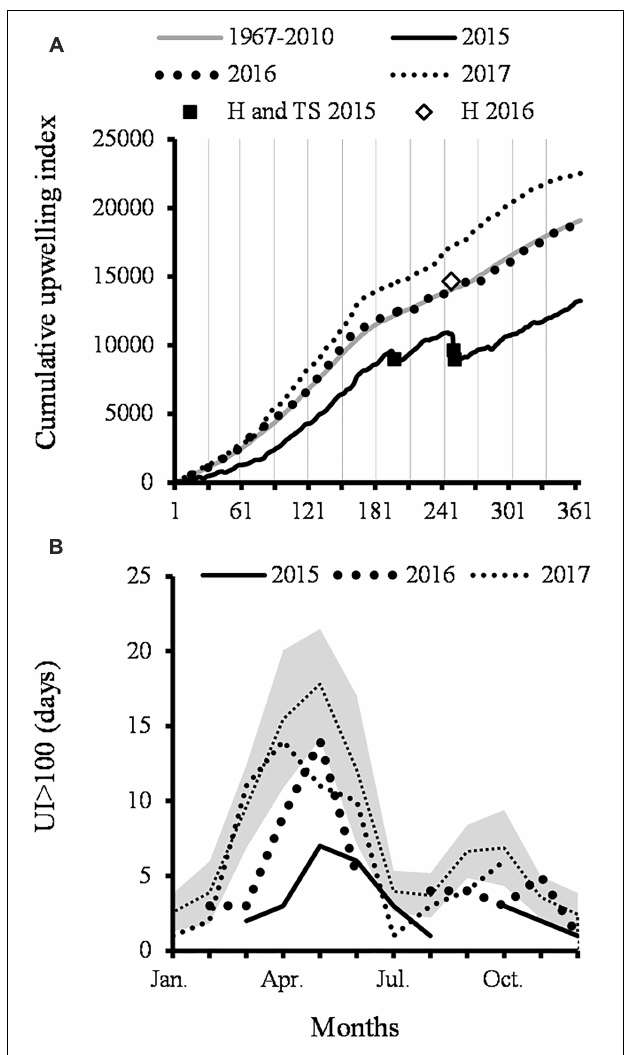
FIGURE 2 | Upwelling phenology. Gray line is 1967–2010 average; H, hurricanes; TS, tropical storm. (A) Cumulative upwelling index of 1967–2010 average and 2015–2017. (B) Days in which the upwelling index was greater 100 m 3 s − 1 100 m coastline (UI > 100). Gray band shows mean ±